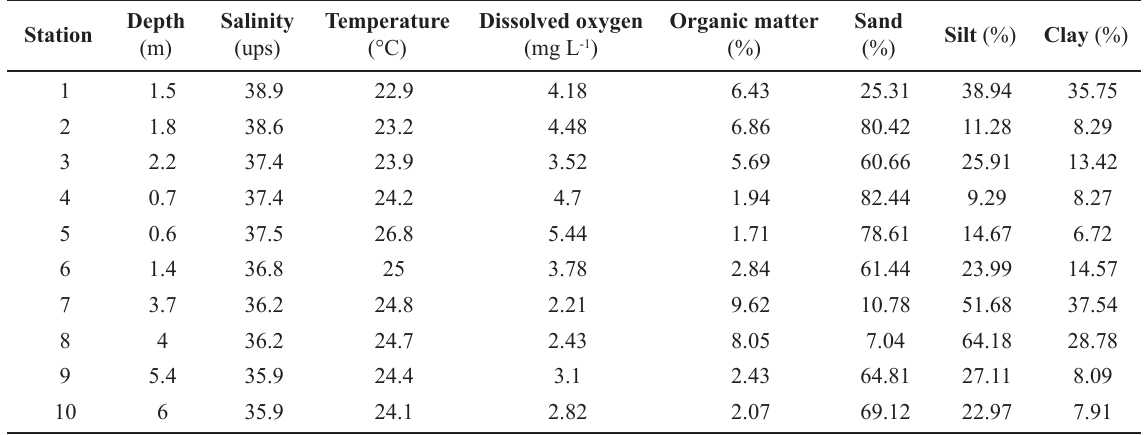
Table 6. Environmental variables at each sampling station along the Urías system recorded on 18 Jan. 2019. See also Gómez (2020a: 43, fig. 1) .